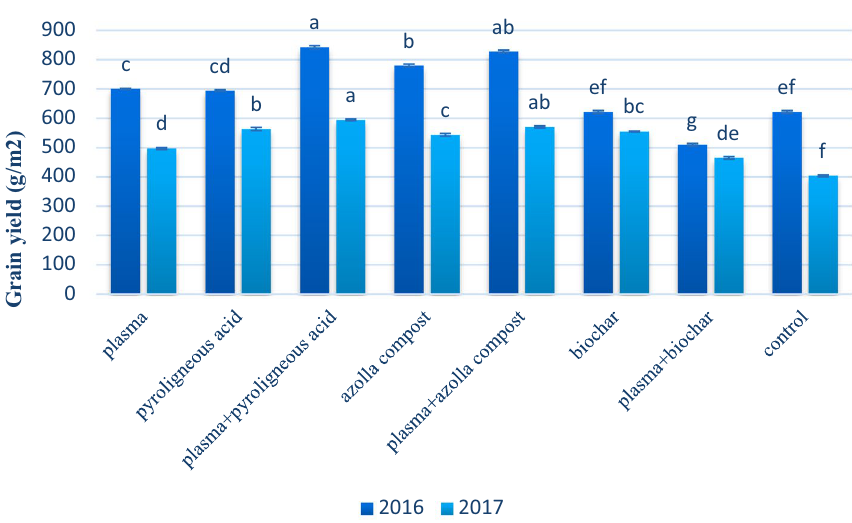
Figure 6. Mean comparison of effect of application of plasma, pyroligneous acid, azolla compost and biochar on grain yield of